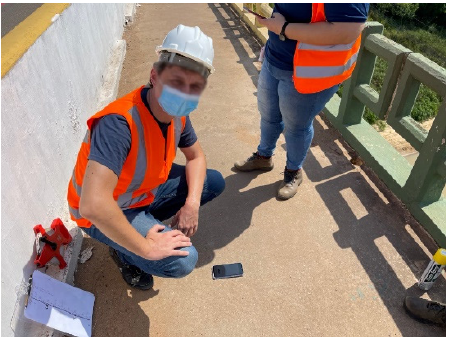
Figure 17. App4SHM being tested at the Itacaiúnas bridges.